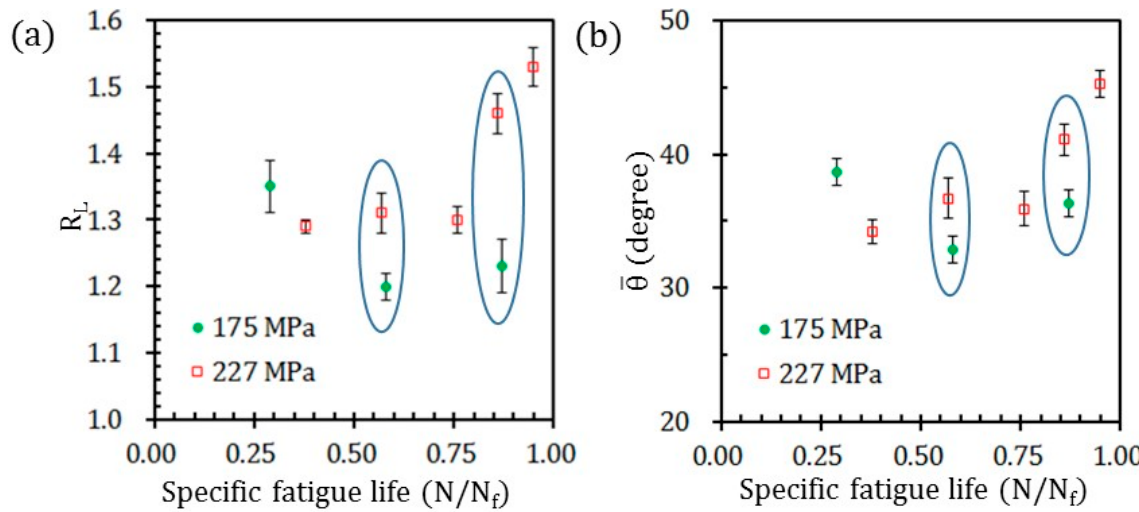
Figure 7. Roughness parameters of samples tested at the stress of 175 and 227 MPa based on the surface crack path profile: ( a ) Linear roughness parameter, R L ; ( b ) Arithmetic mean of the deflection angle, ( θ ). Specific fatigue life denotes the ratio of instantaneous fatigue life (N) to total fatigue life (N f ); the ellipses in ( a , b ) show a comparison at a specific point.